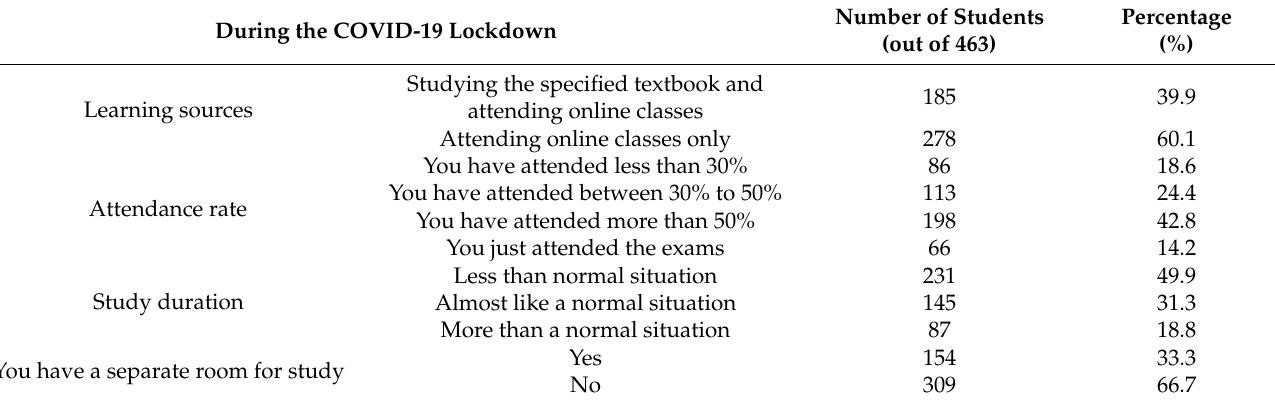
Table 4. Learning sources, attendance rate, study duration, and learning environment during the